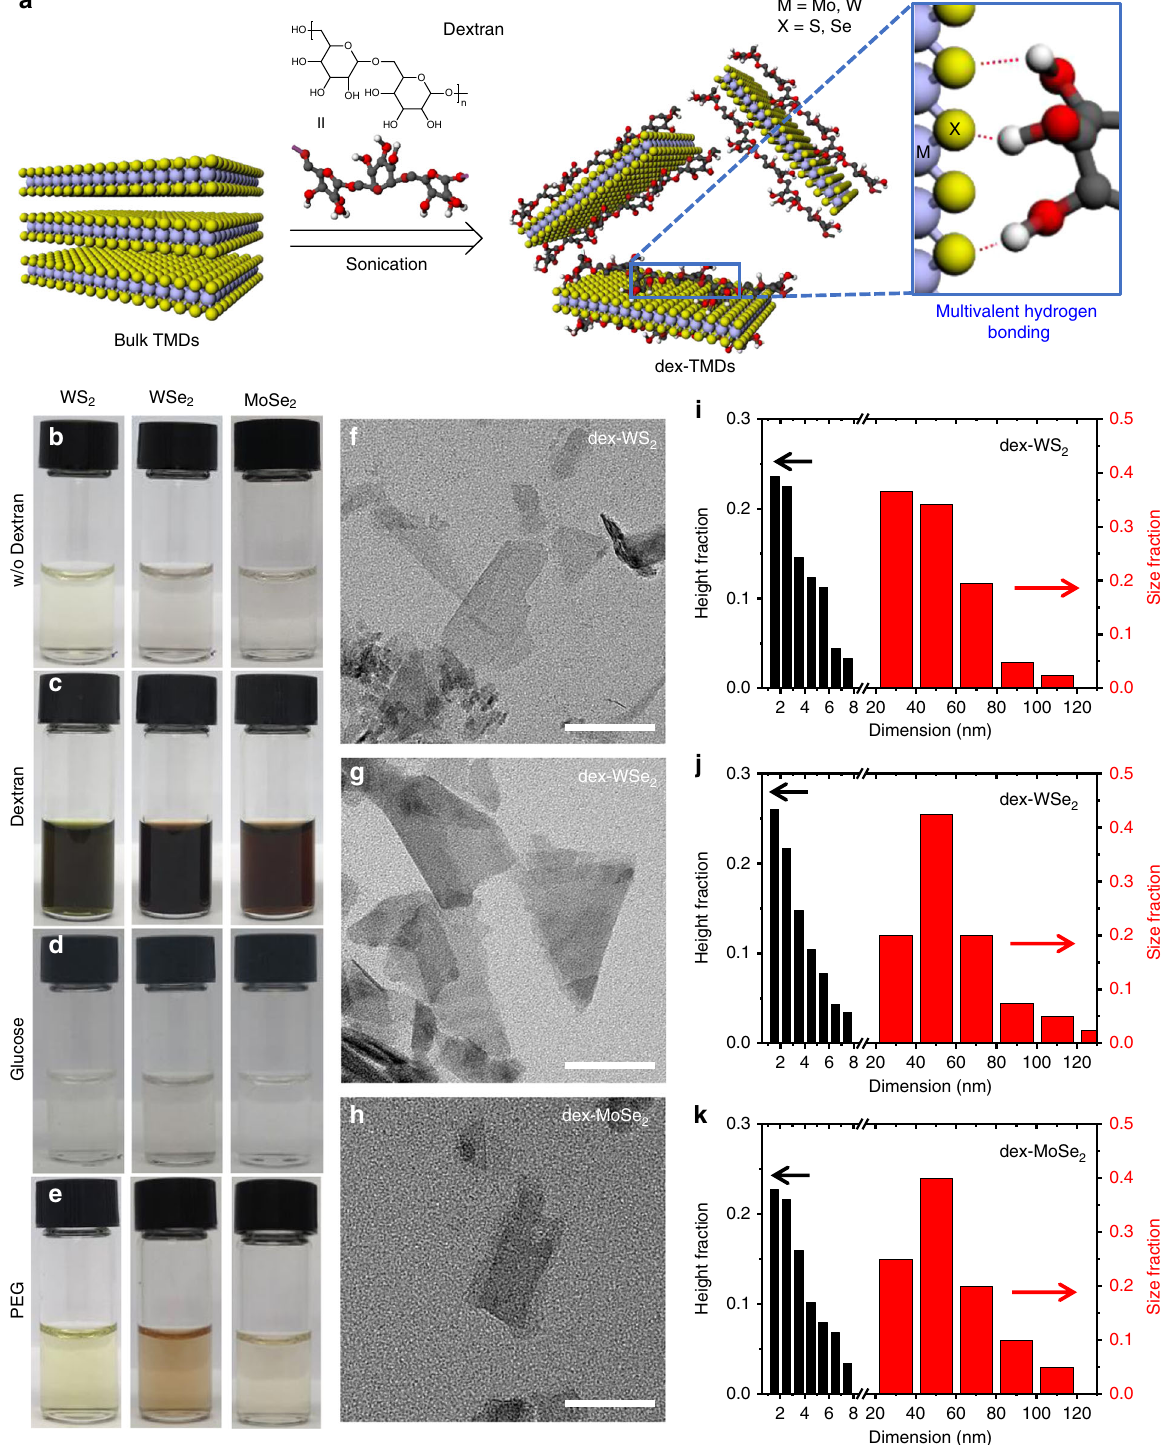
Fig. 1 Simultaneous exfoliation and functionalization of TMDs with dextran. a Schematic illustration of the exfoliation and functionalization of TMDs via multivalent hydrogen bonding in an aqueous solution. Photographs of the solution of TMDs exfoliated b without dextran, c with dextran, d with glucose, and e with PEG. TEM images of f dex-WS 2 , g dex-WSe 2 , and h dex-MoSe 2 (scale bar, 50 nm). Height and lateral size pro fi les of i dex-WS 2 , j dex-WSe 2 , and k dex-MoSe 2 obtained using